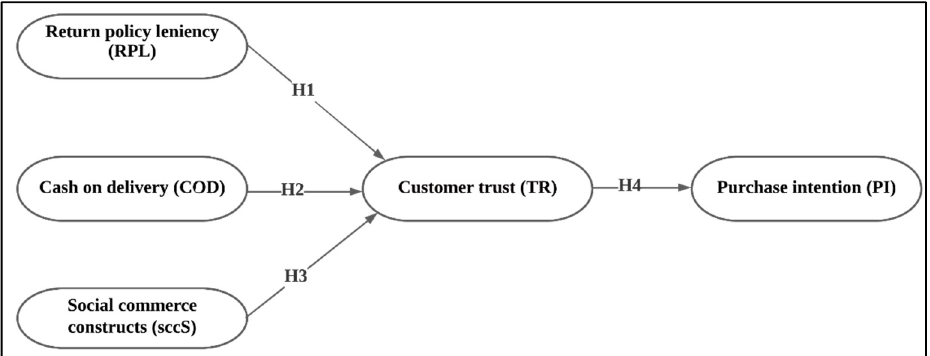
Figure 1. Research